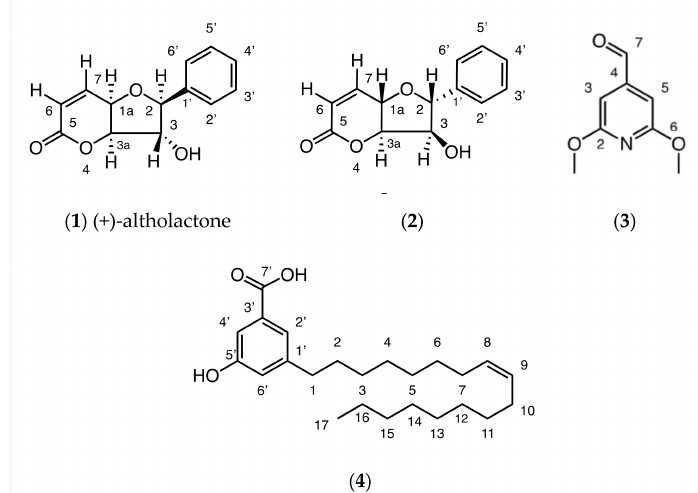
Figure 1. Compounds isolated from Goniothalamus longistipetes —a known styryllactone, ( + )-altholactone ((2 S ,3 R ,3a S ,7a S )-3-hydroxy-2-phenyl-2,3,3a,7a-tetrahydrobenzo-5(4 H )-5-one) ( 1 ), a new styryllactone, (2 S ,3 R ,3a S ,7a S )-3-hydroxy-2-phenyl-2,3,3a,7a-tetrahydrobenzo-5(4 H )-5-one) ( 2 ) as well as a new alkaloid, 2,6-dimethoxyisonicotinaldehyde ( 3 ) and a new alkenyl-5-hydroxyl-phenyl benzoic acid ( 4